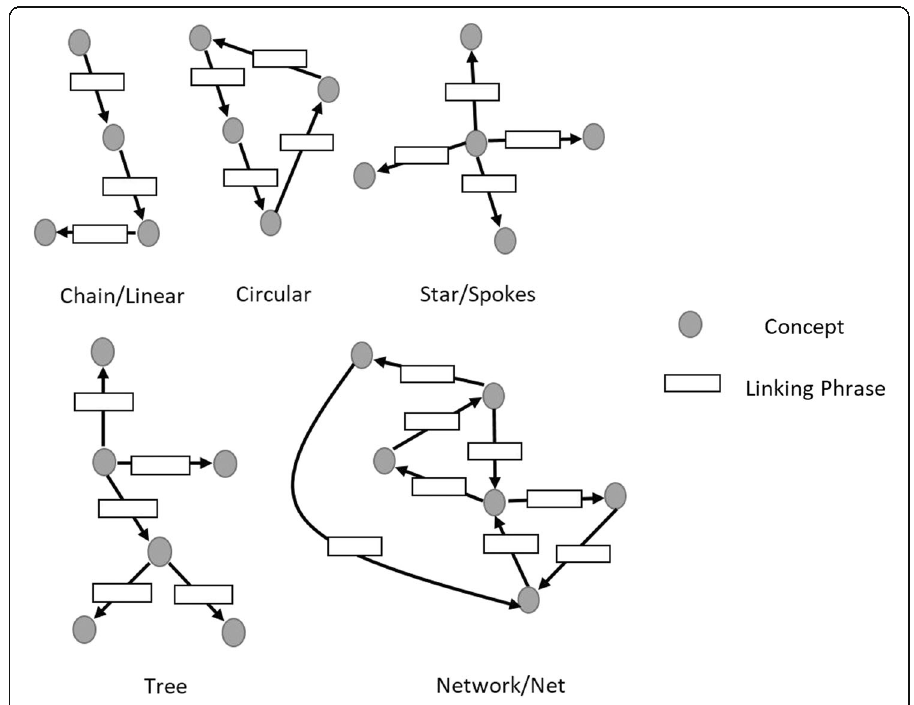
Fig. 1 Structures of concept maps, modified from Yin, Vanides, Ruiz-Primo, Ayala and Shavelson